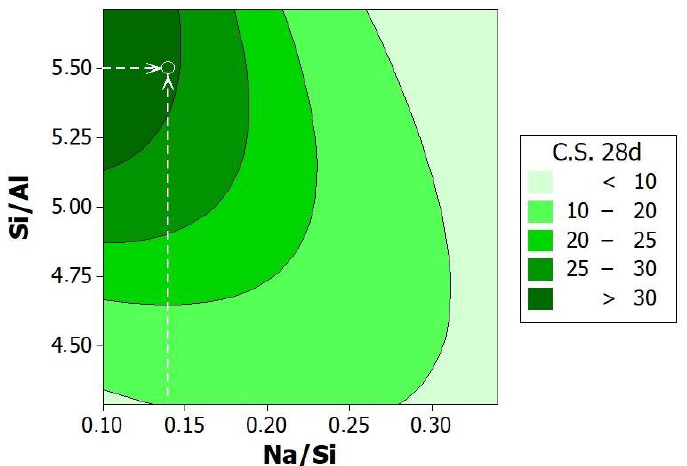
Figure 4. E ff ect of the molar ratios of Na / Si and Si / Al on the compressive strength (C.S.) of hybrid cement (paste) after 28 days of curing (C.S. 28d): the contours represent the strength levels.